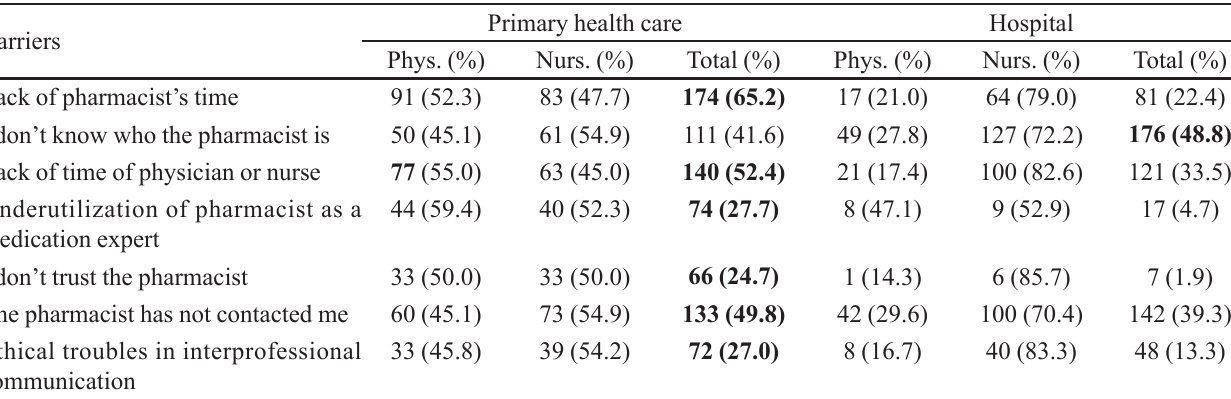
TABLE II - Barriers to interprofessional relationship perceived by participants